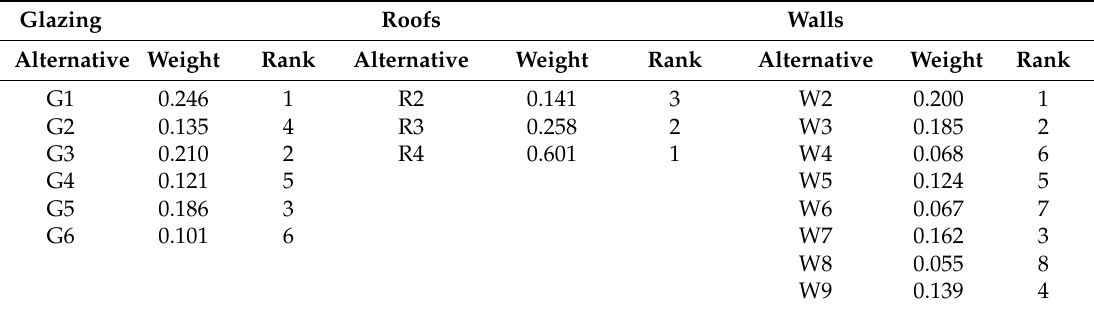
Table 9. Global priority vector for different configurations.